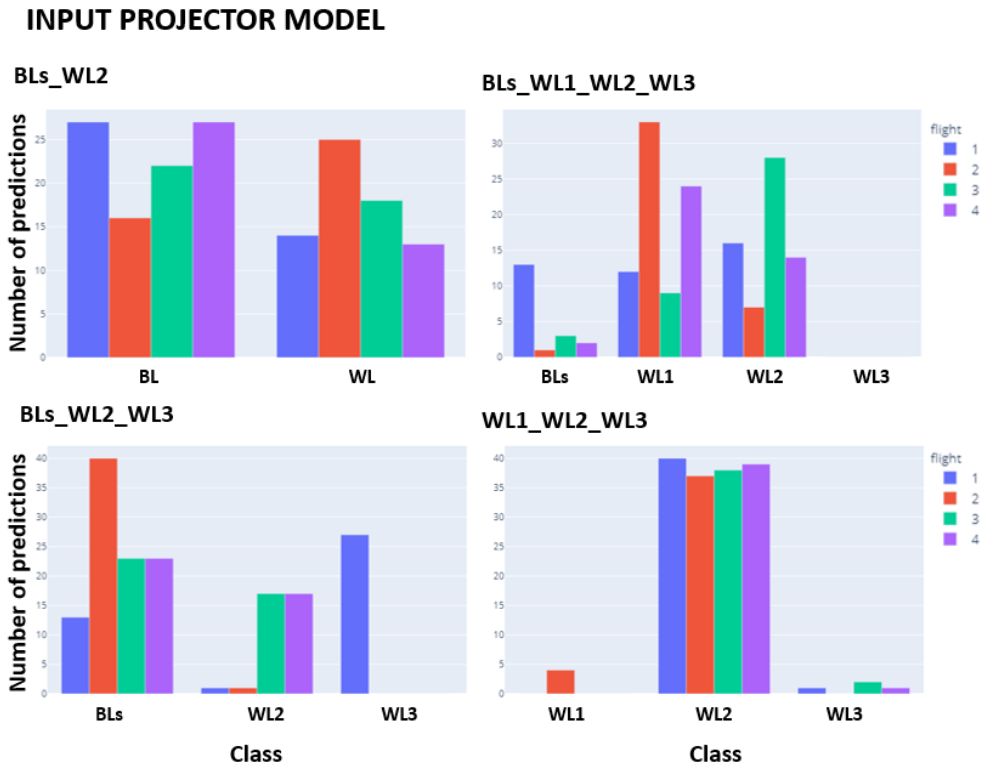
Figure 6. Flight test barplots of WL predictions for the input projector model.